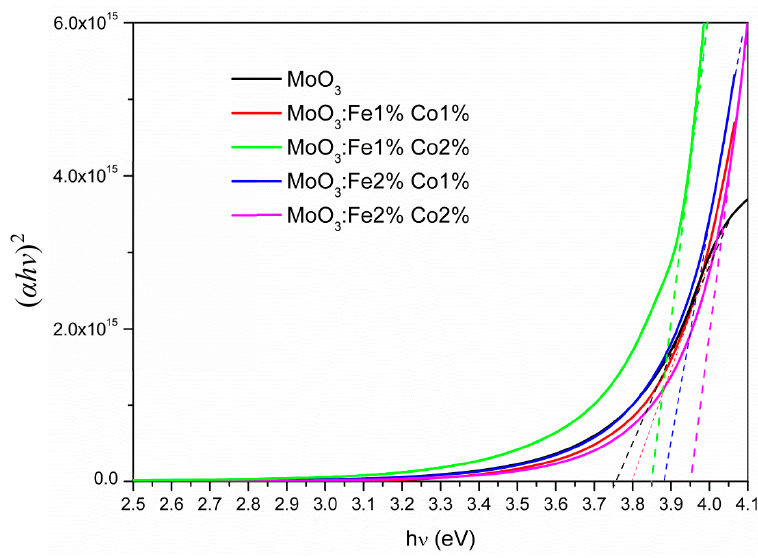
Figure 7. The ( α h ν ) 2 plot vs. h ν for MoO 3 : Fe-Co thin films. Table 5. Optical band gap energy, E g , and Urbach energy, E U , for different content of iron and cobalt in the spray solution.